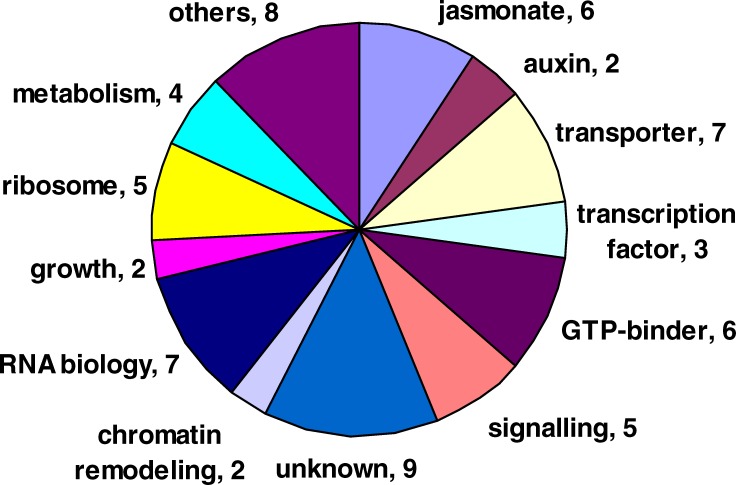
Predicted Functions of 66 Genes Differentially Expressed in the ns1-R Mutant SAMExcluding unknowns and housekeeping genes, 28/40 genes are predicted to function during hormonal-cellular signaling or growth and cell division.